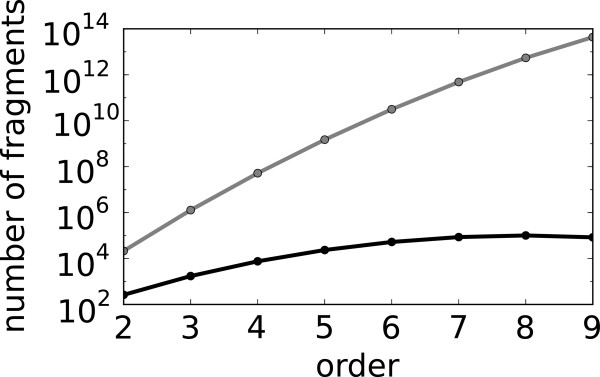
Fragment enumeration for double-layer MAPK mechanism. Number of fragments of different orders generated for the double-layer MAPK network (i) combinatorially (gray) and (ii) generated from the unique correspondence between fragments and edges-only subgraphs (black).